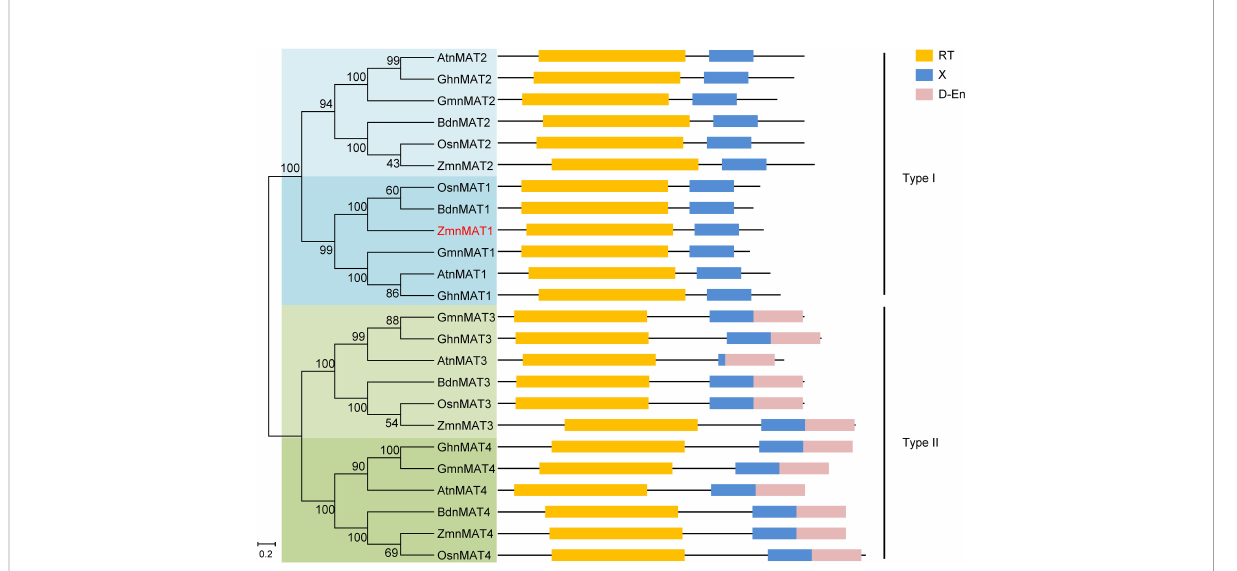
FIGURE 3 Phylogenetic relationships and protein motifs of ZmnMAT1 and its homologs. The ZmnMAT1 protein and its homologs from NCBI were aligned by ClustalW, and the phylogenetic tree was constructed using MEGA 5.0 software. Distances were estimated with a neighbor-joining algorithm, and bootstrap support is indicated to the left of branches. Scale bar indicates the average number of amino acid substitutions per site. RT, X and D-En motifs represent the reverse transcriptase domain, an RNA binding and splicing domain, and DNA-binding endonucleases domain,